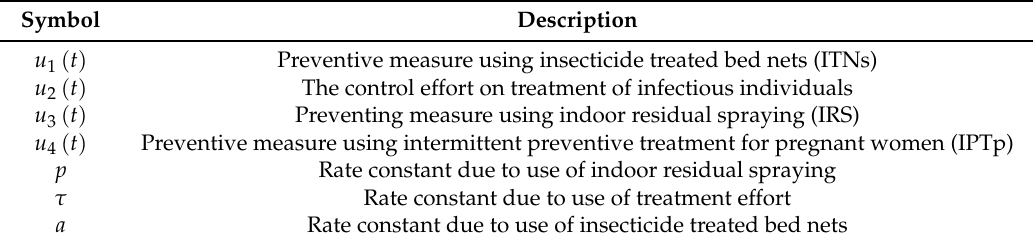
Table 3. Prevention and control variables in the